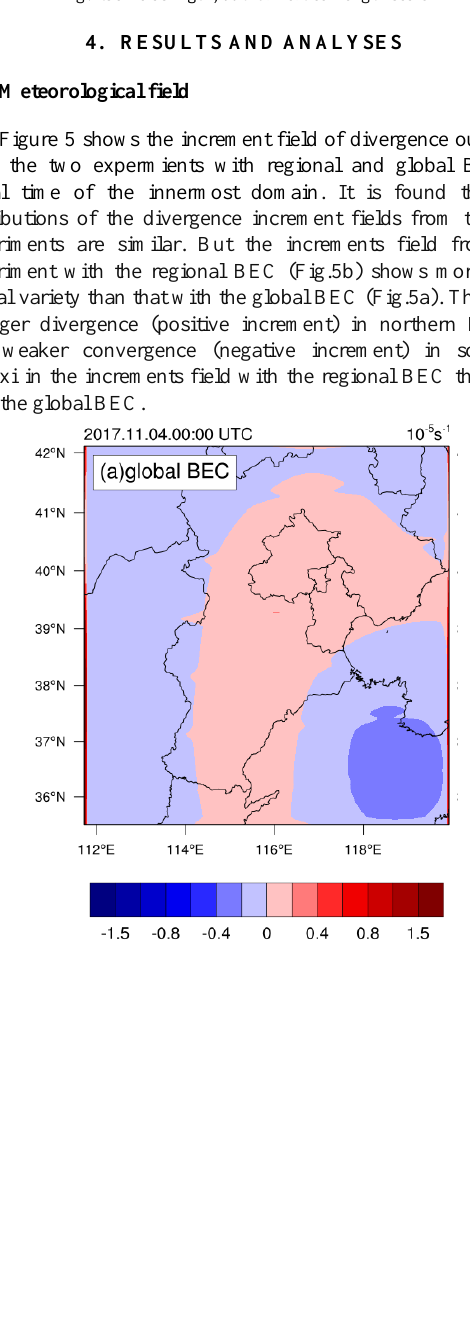
Fig.4.Same as Fig.2, but for vertical length